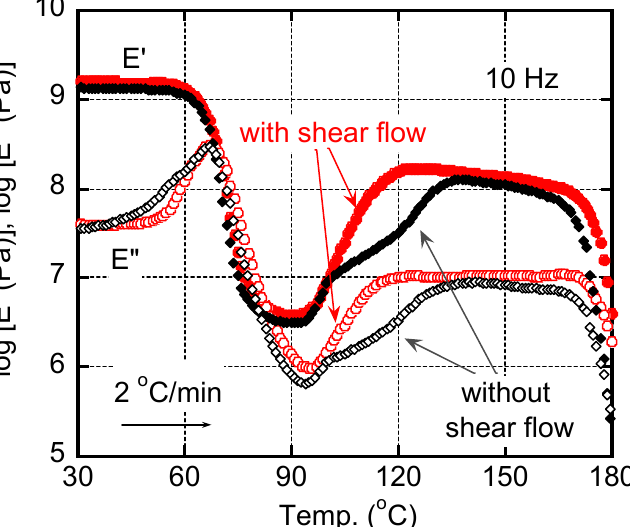
Figure 5. Temperature dependences of tensile storage modulus E ′ and loss modulus E ″ at 10 Hz for the quenched films with/without shear history. The heating rate was 2 °C/min.